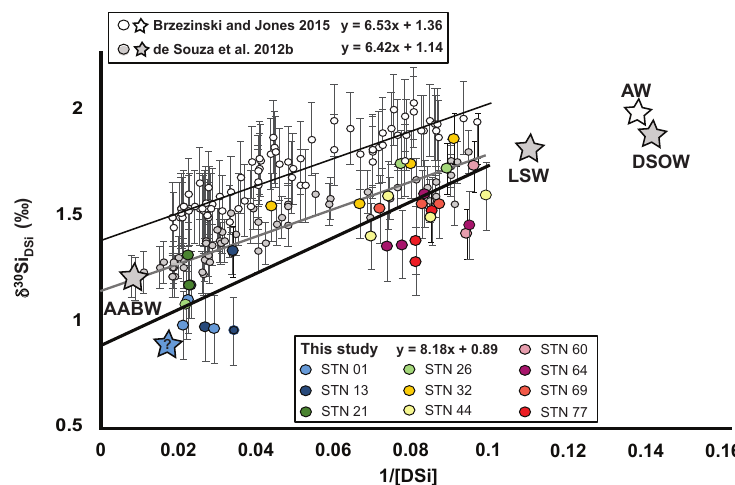
Figure 3. δ 30 Si DSi versus the inverse of DSi concentration for this study (coloured circles identified by station; STN), de Souza et al. (2012b; grey circles) and Brzezinski and Jones (2015; open circles) for waters > 1000m depth. Equations reported in the figure refer to linear regressions produced for each dataset (de Souza et al., 2012b – grey line, y = 6 . 42 x + 1 . 14; Brzezinski and Jones, 2015 – thin black line, y = 6 . 53 x + 1 . 36; this study – thick black line, y = 8 . 18 x + 0 . 89). The statistics associated with each linear regression are as follows: de Souza et al. (2012b) – standard deviation of the slope (SD s ) = 0.31, standard deviation of the y (SD y ) = 0.06, standard deviation of the intercept (SD i ) = 0.02, R 2 = 0.86, n = 58; Brzezinski and Jones (2015) – SD s = 0.32, SD y = 0.07, SD i = 0.02, R 2 = 0 . 83, n = 83; these results – SD s = 1.1, SD y = 0.17, SD i = 0.08, R 2 = 0 . 64, n = 29. The stars presented in this figure represent the end-members for the AABW, LSW, and DSOW previously published by de Souza et al. (2012b – grey stars), the Arctic Water (AW) previously published by Brzezinksi and Jones (2015 – the white star), and an unknown end-member (blue star, see text for